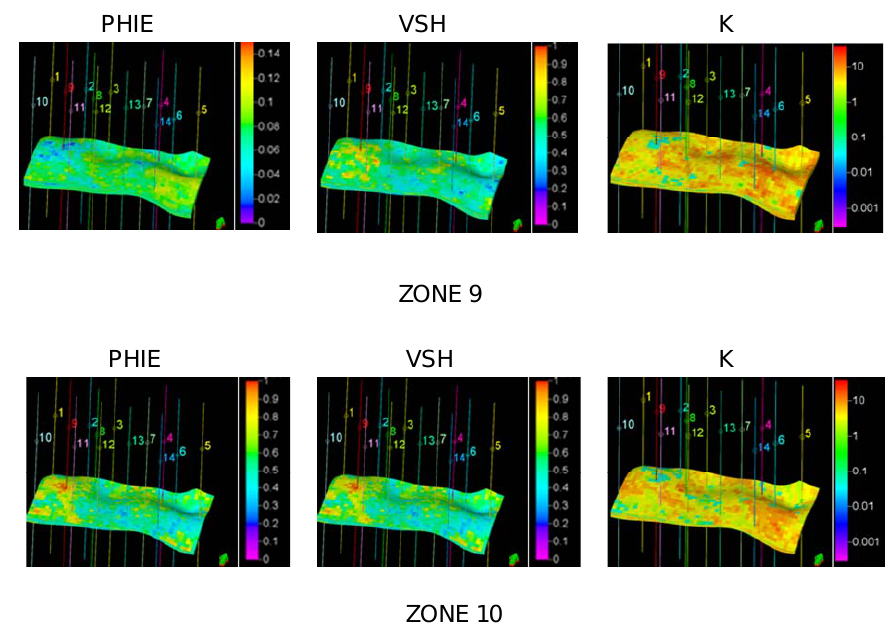
Fig. 10. Fractal distributions of effective porosity (PHIE), shale volume (VSH) and permeability (K) for zones 7 and 8.